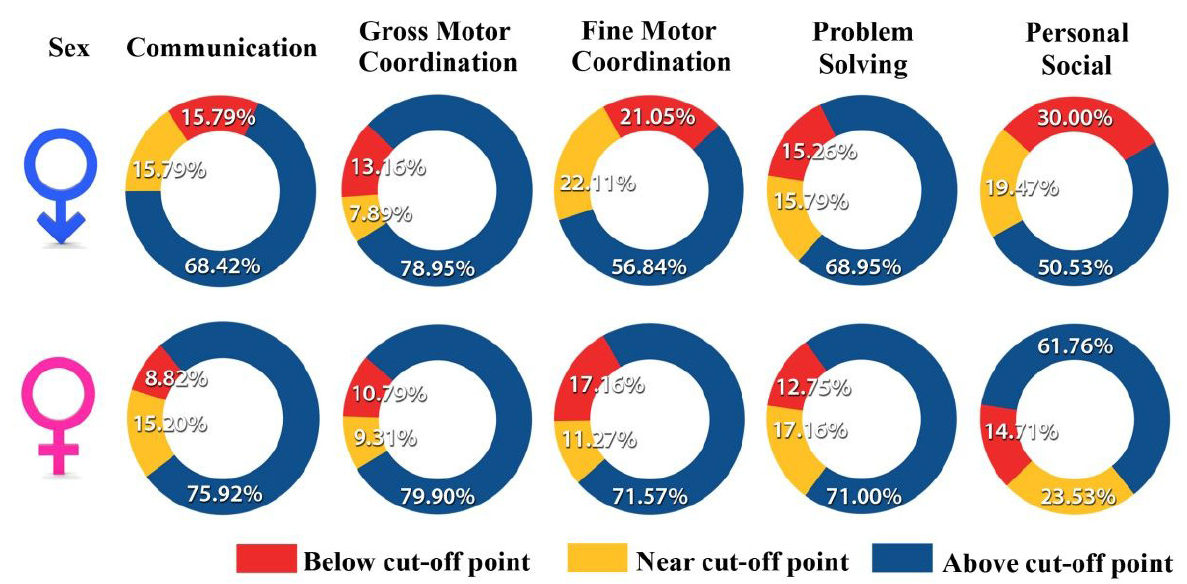
Figure 3. Performance by